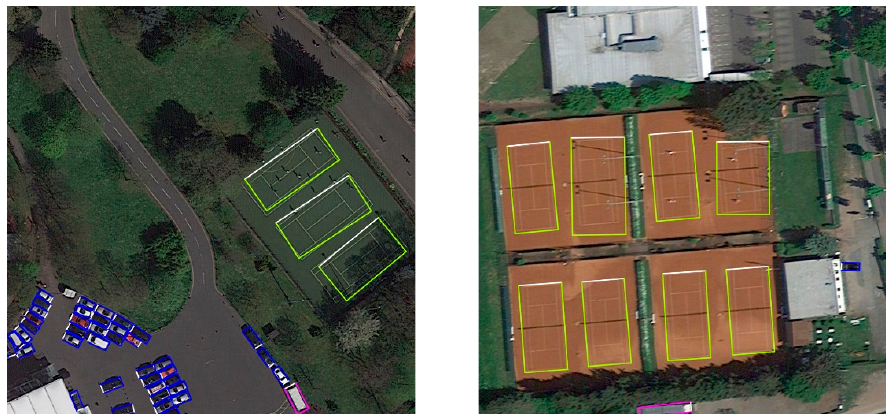
Figure 8. The ambiguous problem of determining the front side of the tennis court. Since any opposite side of a tennis court is symmetrical, it is hard to define its front side clearly. The left detection result treats the longer side as the front side while the right one treats the shorter side as the front side. This makes the detection results inconsistent and leads to imprecise OBB positioning.